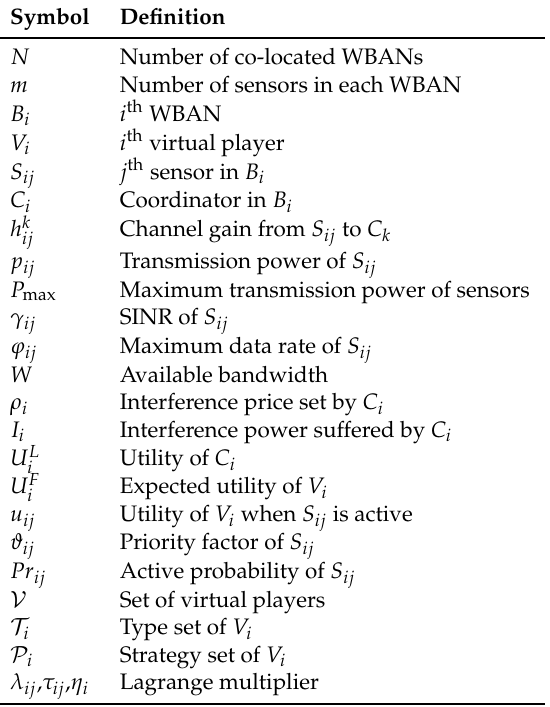
Table 1. Notation